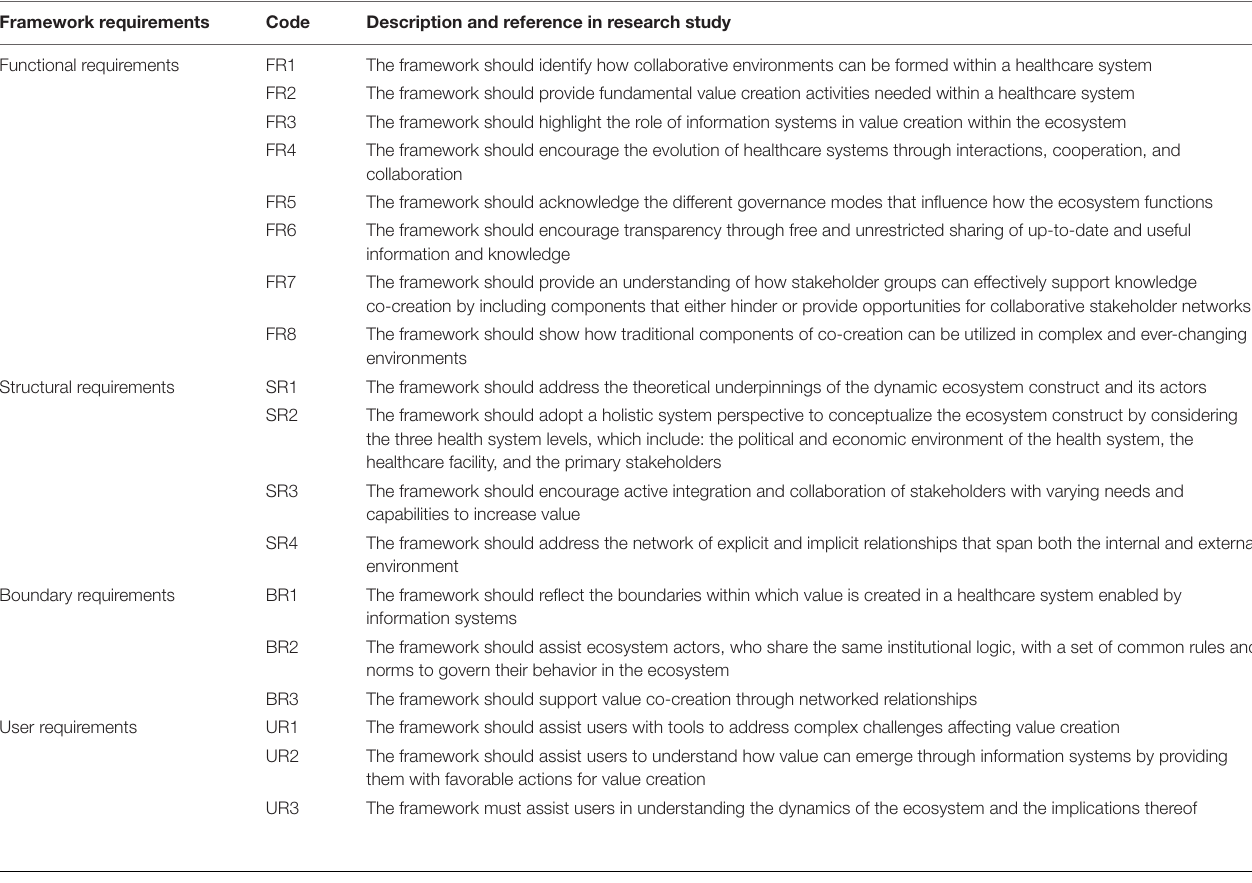
TABLE 2 | Artifact requirements deduced from literature.